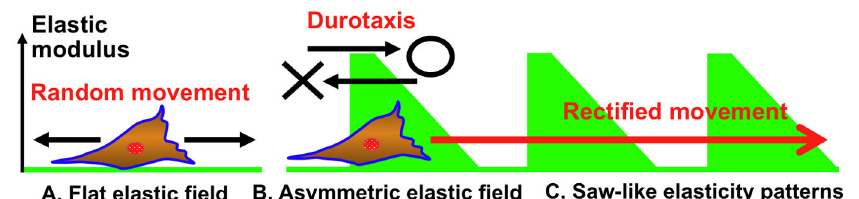
Figure 1. Schematic diagram showing how saw-like asymmetric elasticity patterns are hypothesized to induce rectified cell migration. (a) Cells move randomly when substrate elasticity is homogeneously distributed. (b) On a surface with asymmetric elasticity, cells move by durotaxis towards regions with high elasticity across boundaries that have an elasticity gradient above a threshold level. Biased cell migration does not occur at boundaries that have an elasticity gradient below this threshold level. (c) Cells that migrate across the region with peak elasticity do not migrate back to the less rigid area. Instead, they enter the adjoining unit area. This process can lead to long-range cell migration via a mechanism similar to that of the Feynman ratchet. doi: